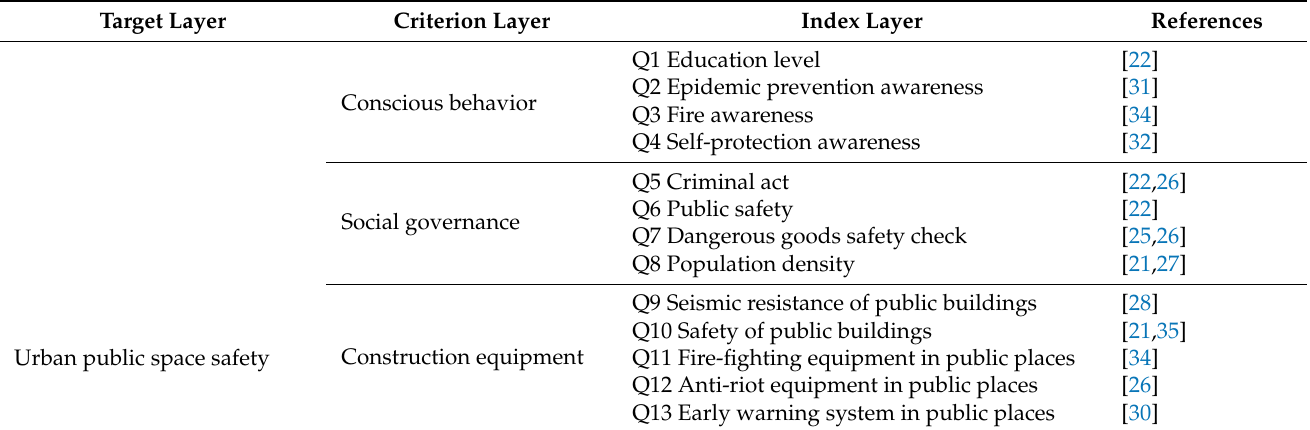
Table 2. Urban public space safety evaluation index